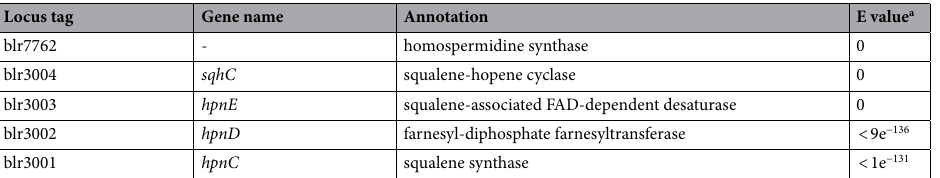
Table 2. Genes deemed essential in Bd110 spc4 that are common to a subgroup of the Bradyrhizobiaceae. a The top BlastP hits to each of the Bd110 spc4 genes listed were to species in the following genera: Tardiphaga , Oligotropha , Afipia, Nitrobacter and Rhodopseudomonas . The gene numbering is that of strain USDA110. Top BlastP hits to orthologous genes from Rhodpseudomonas palustris strain CGA009 were also to species in these genera. The highest expect value for the all the gene homologues identified by BlastP is given. The NCBI RefSeq select protein database was used for the BlastP searches.